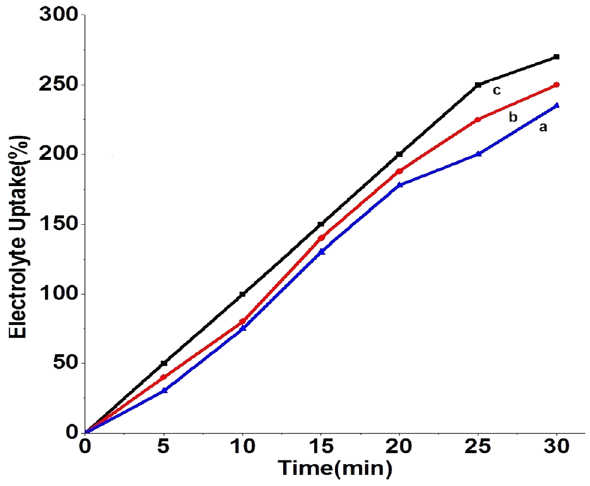
Fig. 7 Porosity, electrolyte uptake and ionic conductivity of PVdF, PVdF–PMMA (80:20) and PVdF–PMMA (50:50) nanofibrous mem-